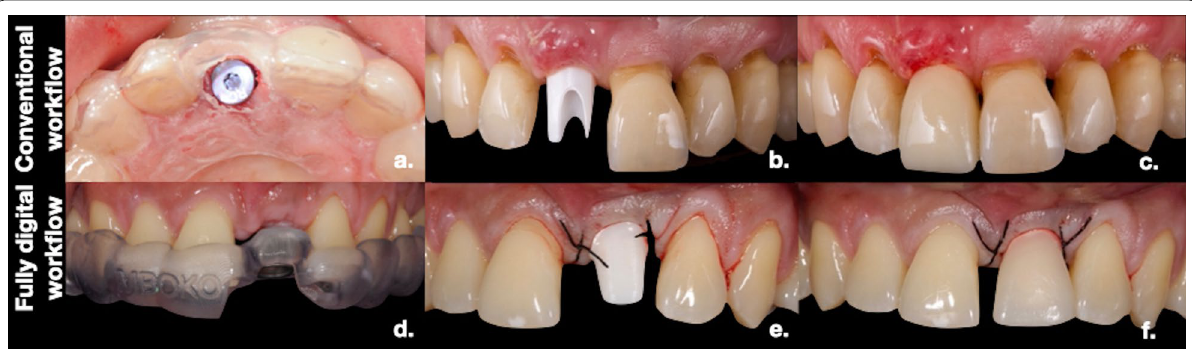
Fig. 1 Clinical steps of the conventional and fully digital workflows: Conventional group: a surgical guide in the control group; b placement of the custom-made zirconia abutment at 10 day post-surgery; c provisional crown made of stratified PMMA. Fully digital group: d s-CAIS guide; e placement of the custom-made abutment right after surgery; f provisional CAD–CAM